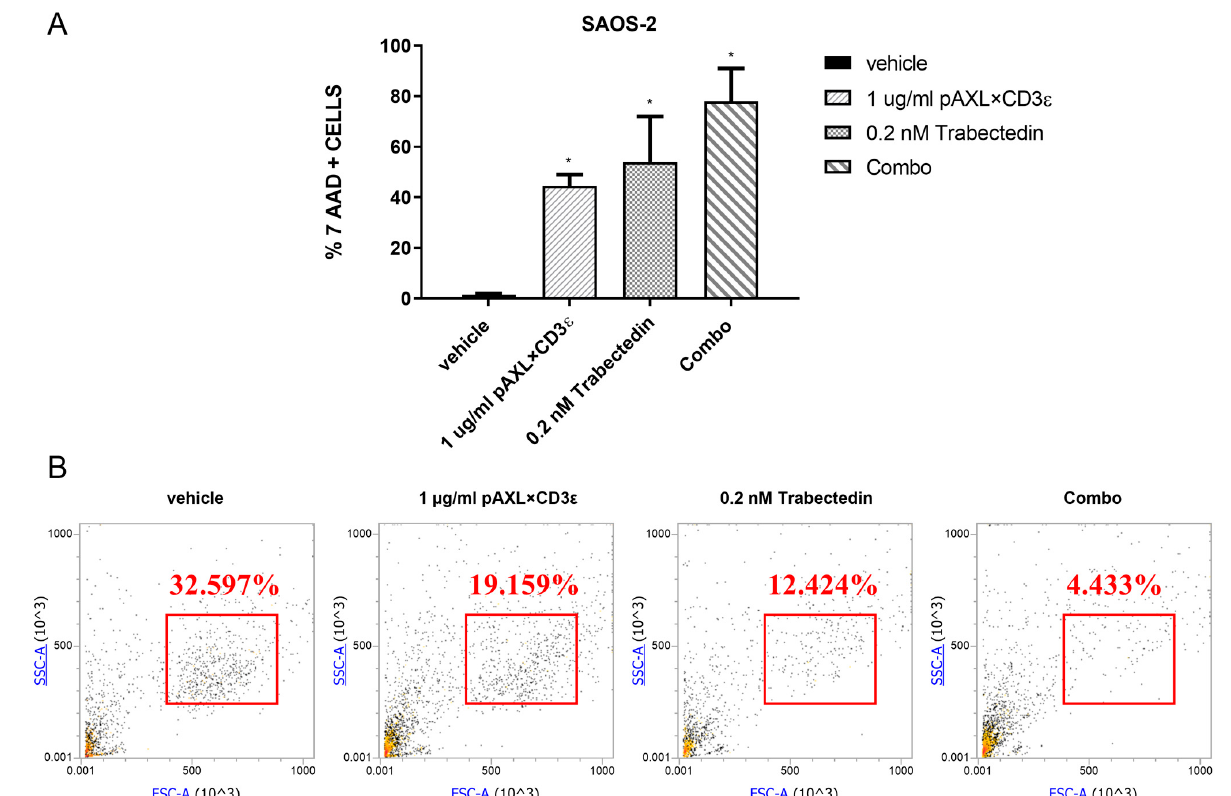
Figure 5. pAXL×CD3 ε sensitizes chemotherapeutic drug activity in vitro. ( A ) Redirected cytotoxicity T-cell of pAXL×CD3 ε in SAOS-2, analyzed in co-culture experiments using 1 µg/mL of pAXL×CD3 ε , 0.2 nM of trabectedin and their combination (Combo) for 72 h. ( B ) Representative dot plots of SAOS-2 viability reduction (%) after treatment with pAXL×CD3 ε and trabectedin alone or in combination. PBMCs were obtained from 3 healthy donors and results are expressed as the mean value of triplicate experiments from each donor. * p < 0.0332.